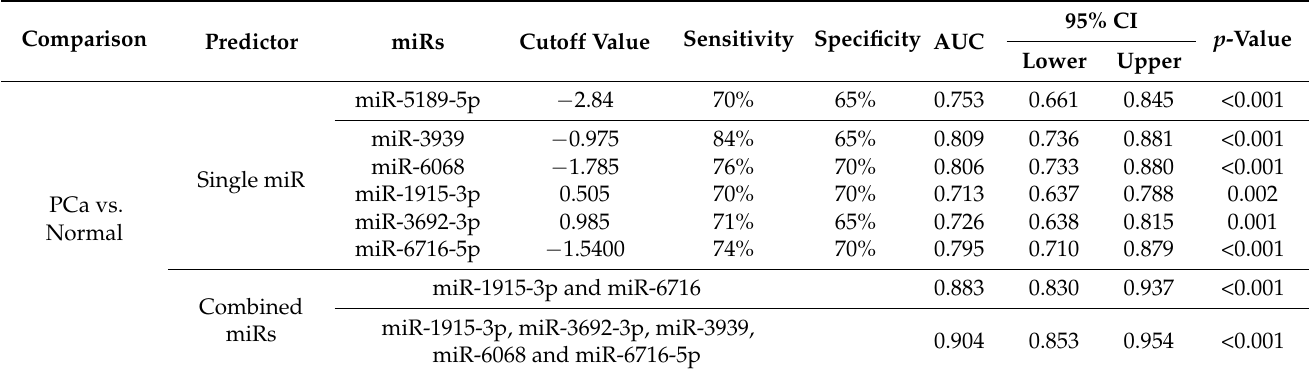
Table 3. Diagnostic ability of individual and combined sEV-associated miRs ( ∆ CT) to differentiate PCa from normal individuals and AA from CA men in plasma collected from PCa patients in confirmatory cohorts. Comparison Predictor miRs Cutoff Value Sensitivity Specificity AUC